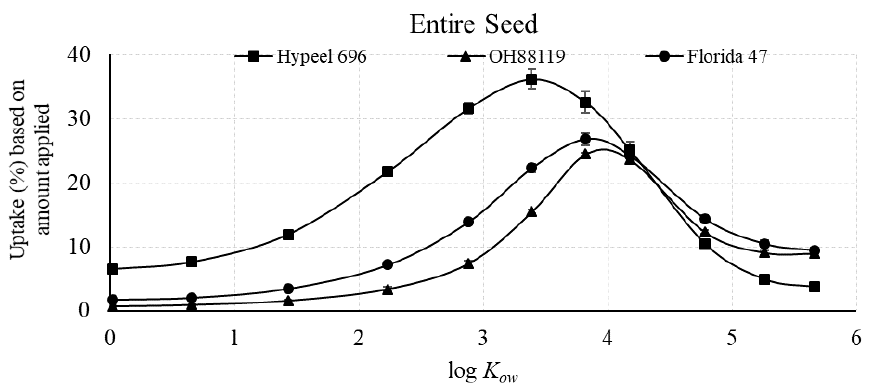
Figure 6. Uptake efficiency of piperonyl amides in the seed, measured as percent compound applied of n -alkyl piperonyl amides. Means with standard error bars are shown.